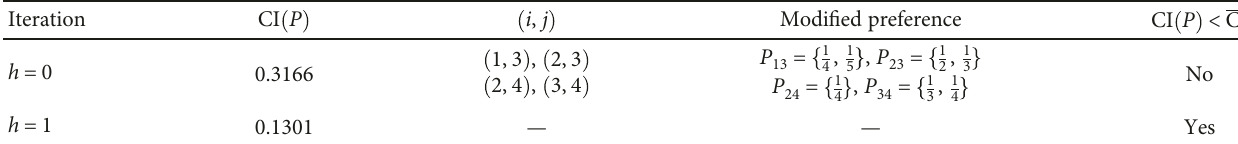
Table 3: Consistency-improving process for P